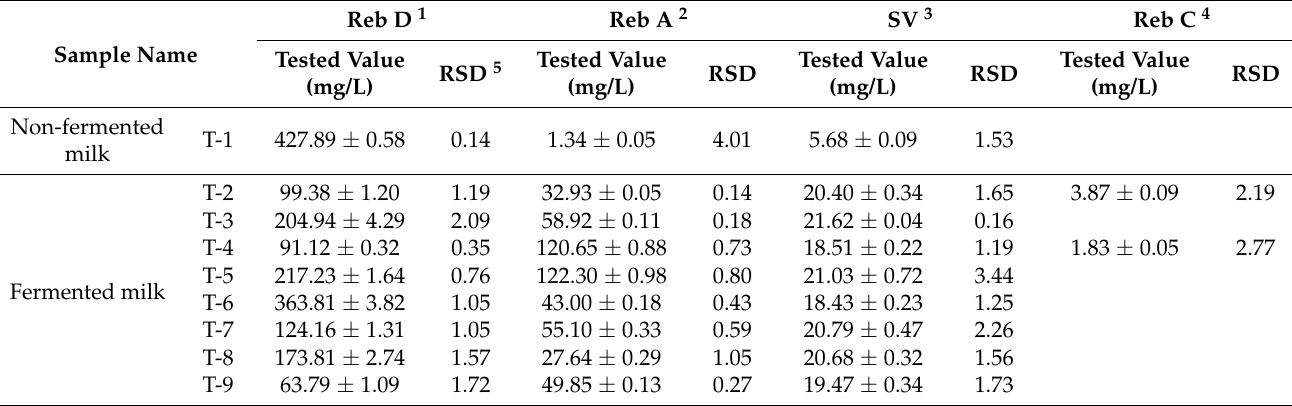
Table 3. Estimation of the steviol glycoside contents in nine commercially available dairy